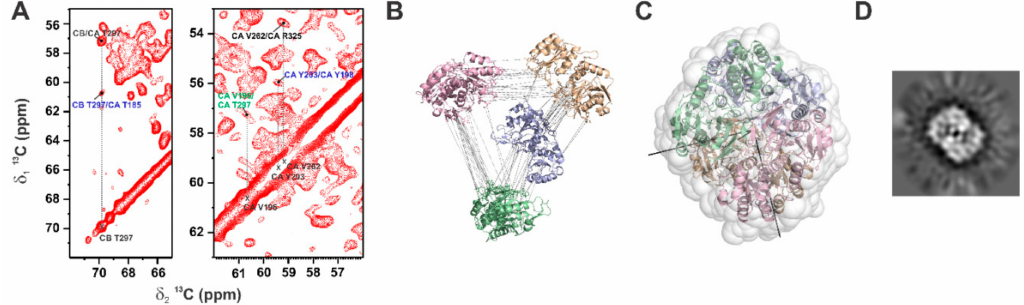
Figure 1. ( A ) Enlargement of two regions of the 2D 13 C- 13 C DARR (Dipolar Assisted Rotational Resonance) solid-state NMR (SSNMR) spectrum (mixing time 200 ms) displaying long-range inter-residue restraints (blue interdimer and green interdomain / intramonomer). ( B ) Representation of the 21 intermonomer distance restraints used in HADDOCK calculations. Ten of these restraints define the interface between the two monomers (chains A and C in wheat and pink, respectively) forming the intimate dimer, whereas eleven define the interface between other two monomers (chains A and D in wheat and light-blue, respectively). The restraints were replicated according to the protein symmetry. ( C ) Structural model with the lowest energy obtained with HADDOCK calculations, implementing SSNMR experimental restraints and residual dipolar couplings (RDCs) restraints. The PEG chains are schematized as white spheres. ( D ) Cryo-electron microscopy (cryo-EM) 2D classes of ANSII PEGylated with PEG 5000. The figure is an adaptation from Reference